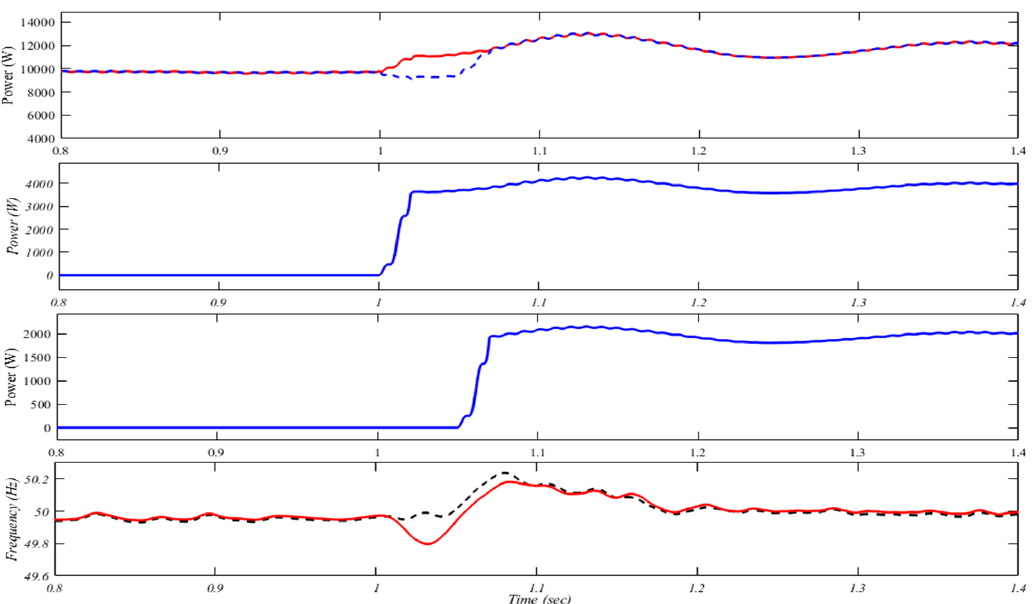
Figure 9. Active power and frequency in interconnected condition when CMG 1 and CMG2 are both overloaded.